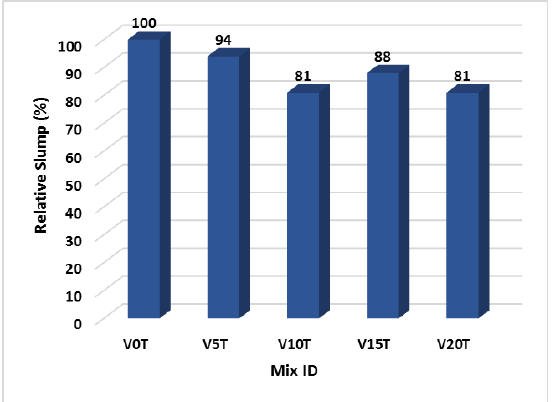
Figure 7. Effect of VA ratio on the slump of volcanic concrete made with tap